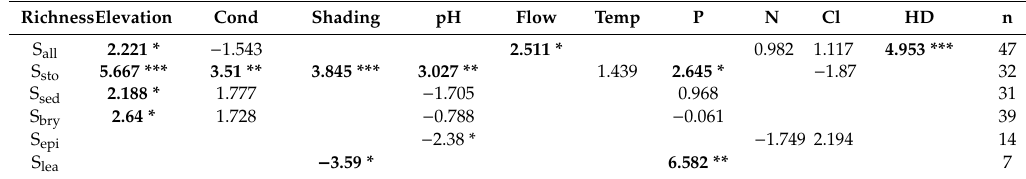
Table 1. Results of the quasi-Poisson regression and stepwise AIC model selection using environmental factors as independent and species richness as dependent variable. Entry cells are z-values (the regression coe ffi cients divided by its standard error). Statistically significant values are in bold. Species richness = number of diatom species per sampling site, elevation [m], cond = conductivity [ µ S / cm], temp = temperature [ ◦ C], flow = flow velocity and shading in a five-point scale according to Cantonati et al. (2007), P = Total Phosphorus (TP), N = NO 3 -N − [mg / L], Cl = Cl − [mg / L], HD = Habitat Diversity (number of available substrates) Significance: ◦ = p ≤ 0.1, * = p ≤ 0.05, ** = p ≤ 0.01, *** = p ≤